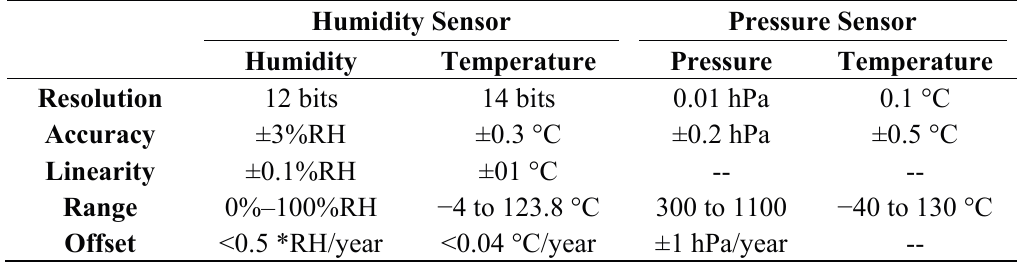
Table 8. Specifications of the humidity and pressure